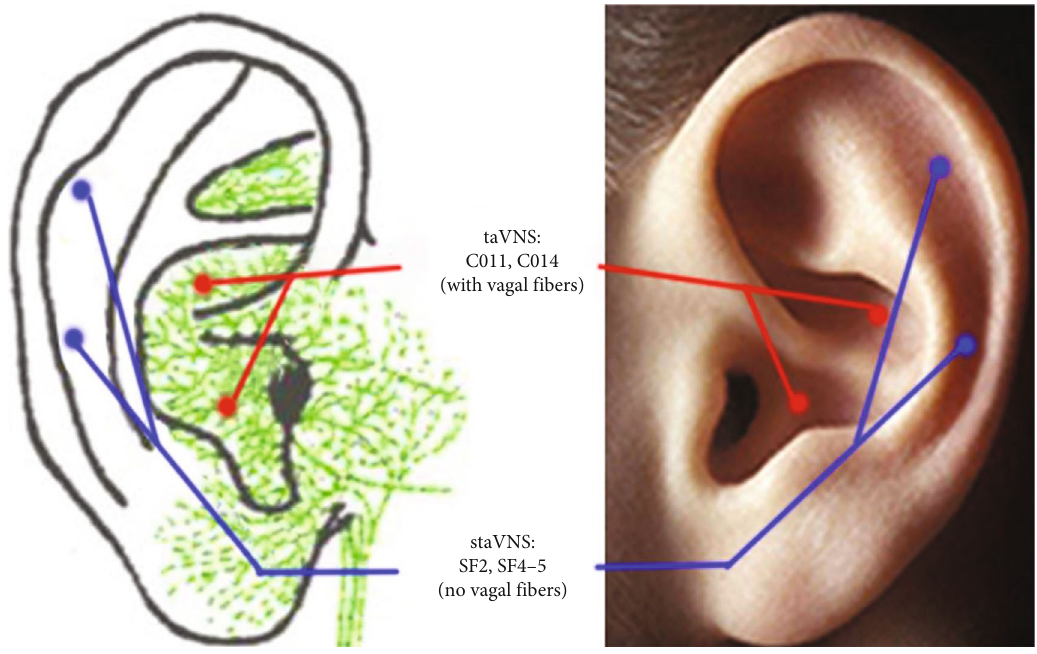
Figure 1: The innervations of the auricular branch of the vagal nerve and the points stimulated at the ear. The vagal nerve branch is marked by green color, the taVNS points by red, and the staVNS points by blue.